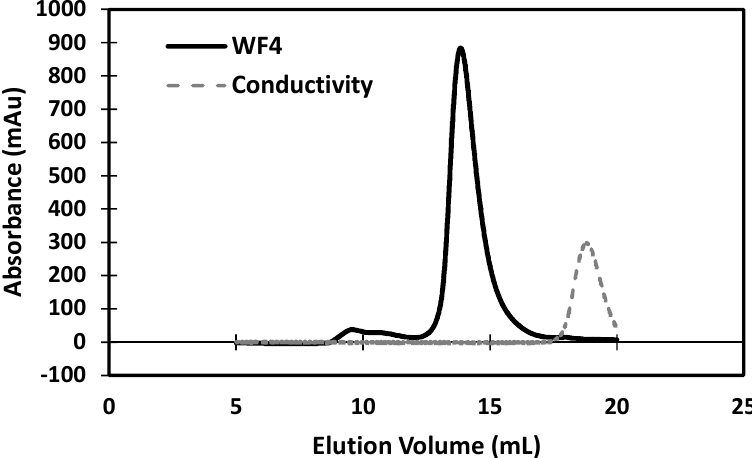
Figure A1. Representative gel-filtration chromatography trace.